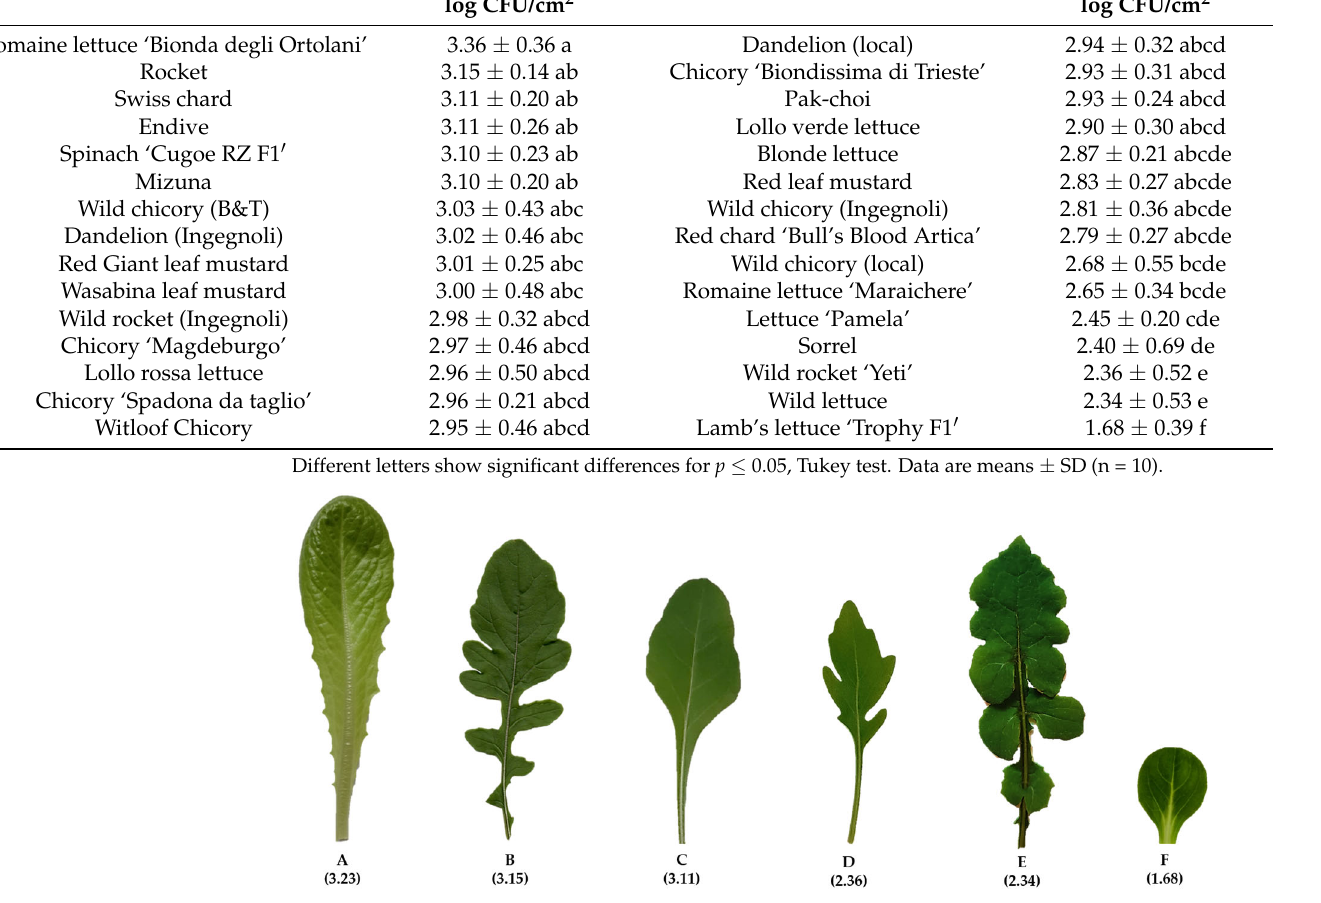
Table 2. E. coli ATCC 35218 attachment in 30 accessions of baby leaves.